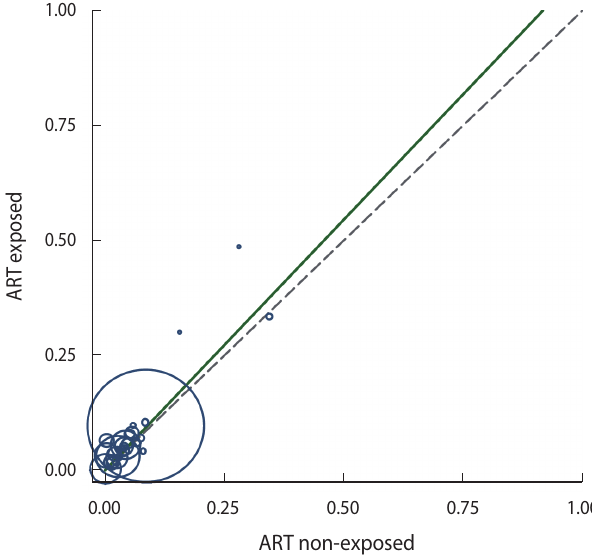
Figure 5. L’ Abbé plot depicting a summary of the effects of antiret- roviral therapy (ART) on congenital